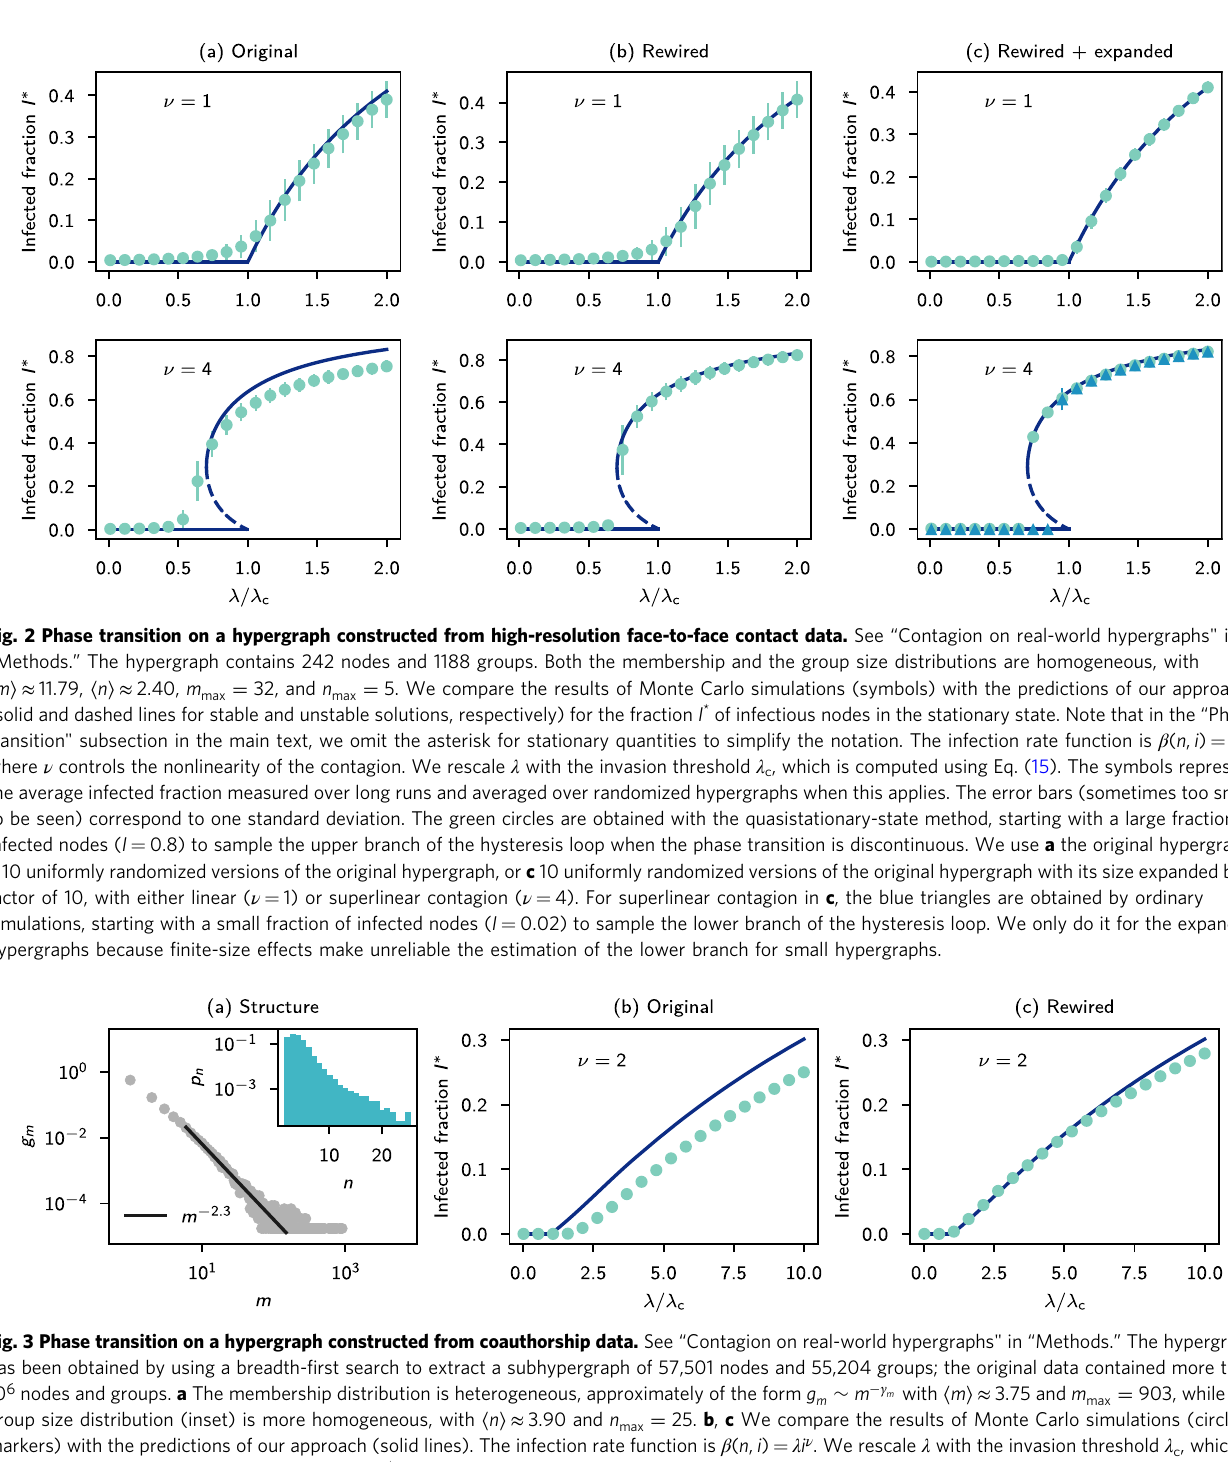
regime appears. These results are valid for any infection rate func- tion such that β ( n , i ) > 0 for all i > 0 (see Supplementary Note 3 for a consideration of threshold models).